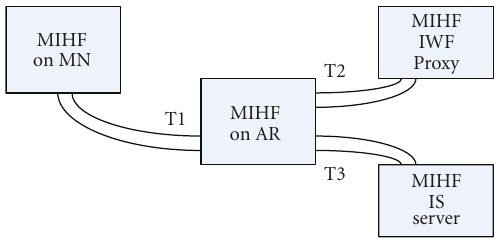
Figure 8: MIH message security through endpoint to gateway